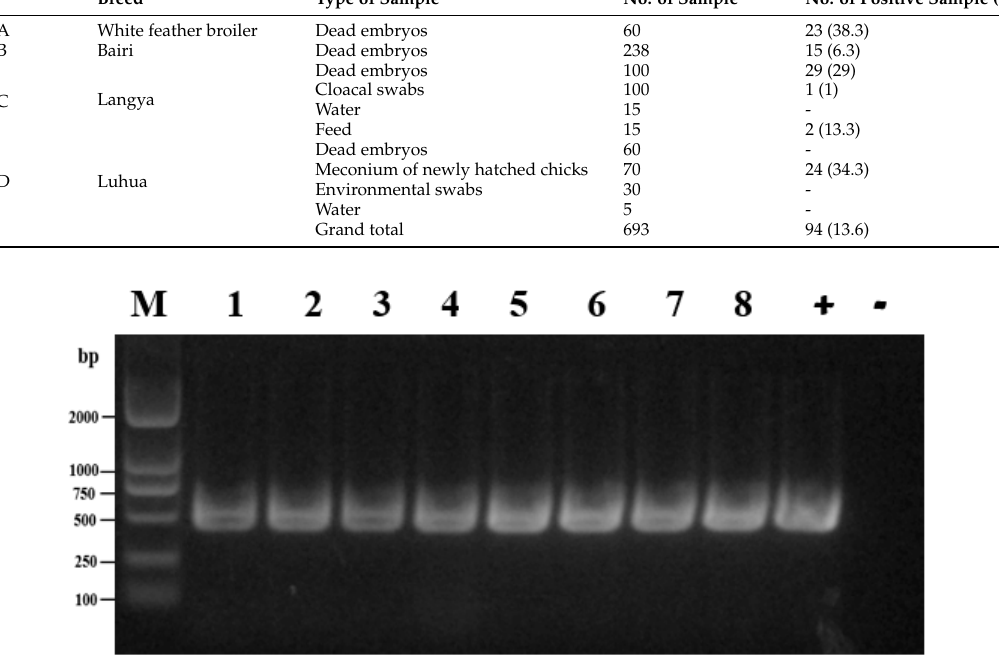
Figure 1. PCR assays for the detection of Salmonella spp. isolates. M: molecular weight standards of DL 2000; Lane 1–8: Eight Salmonella strains; +: positive control ( S. enteritidis CVCC 3377); − : Negative control ( Escherichia coli ATCC 25922).